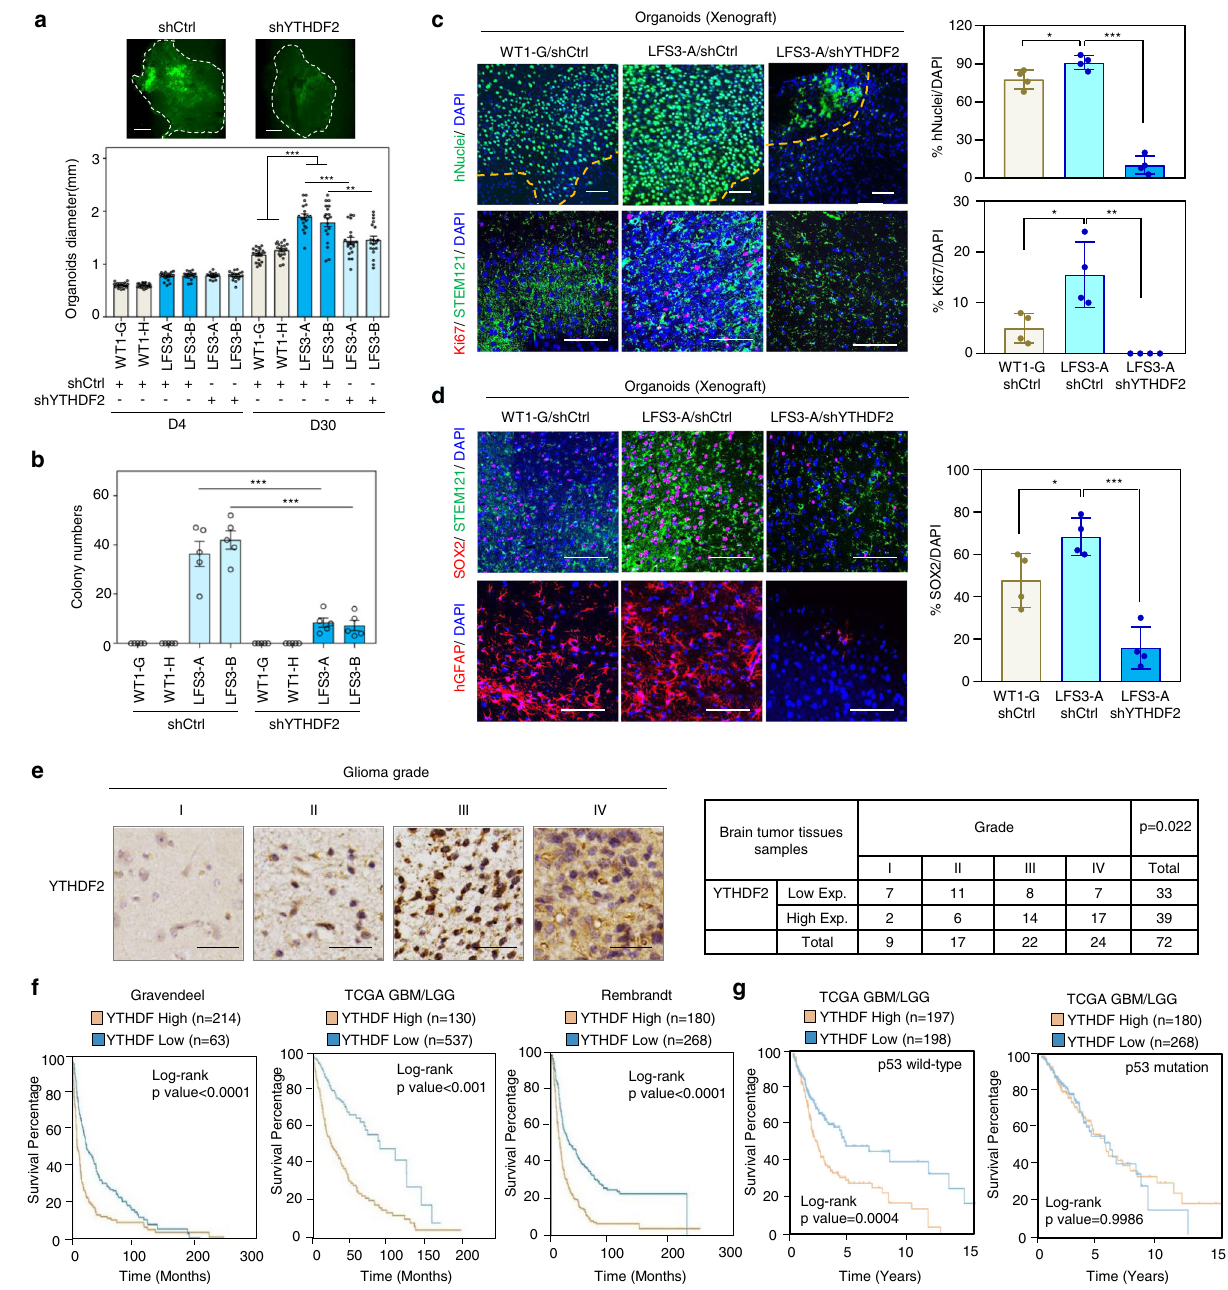
Fig. 2 | YTHDF2is associated withmutantp53-induced neomorphic oncogenic function and its expression is correlated with poor prognosis in glioma patients. a Knockdown of YTHDF2 leads to decreased LFS cerebral organoid development. The average diameters of shCtrl- and shYTHDF2-transduced LFS organoids and WT organoids are quanti fi ed at 4 and 30 days ( n =19 biologically independent samples). Scale bar, 500 µ m. b In vitro AIG assay demonstrates decreased colony numbers upon YTHDF2 depletion in LFS astrocytes ( n =5 bio- logically independent samples). All colonies are counted and measured after 2-month culture. c Immuno fl uorescence staining of engrafted cerebral organoids in mouse cortices is used to determine organoid size and cell proliferation. Upper panel: Organoid engraftment is determined by the presence of human nuclear antigen (hNuclei) in mouse cortex and quanti fi ed by the percentage of stained (mouseorhuman)nuclei(DAPI)inthemicroscopic fi eldstainingforhNuclei.Lower panel: The proliferative human cells (STEM121 + cells) in engrafted organoids are determined by quantifying the percentage of Ki67 over DAPI ( n =4 biologically independentsamples).Barplots displaythe hNuclei + /DAPI + and Ki67 + /DAPI + ratios.